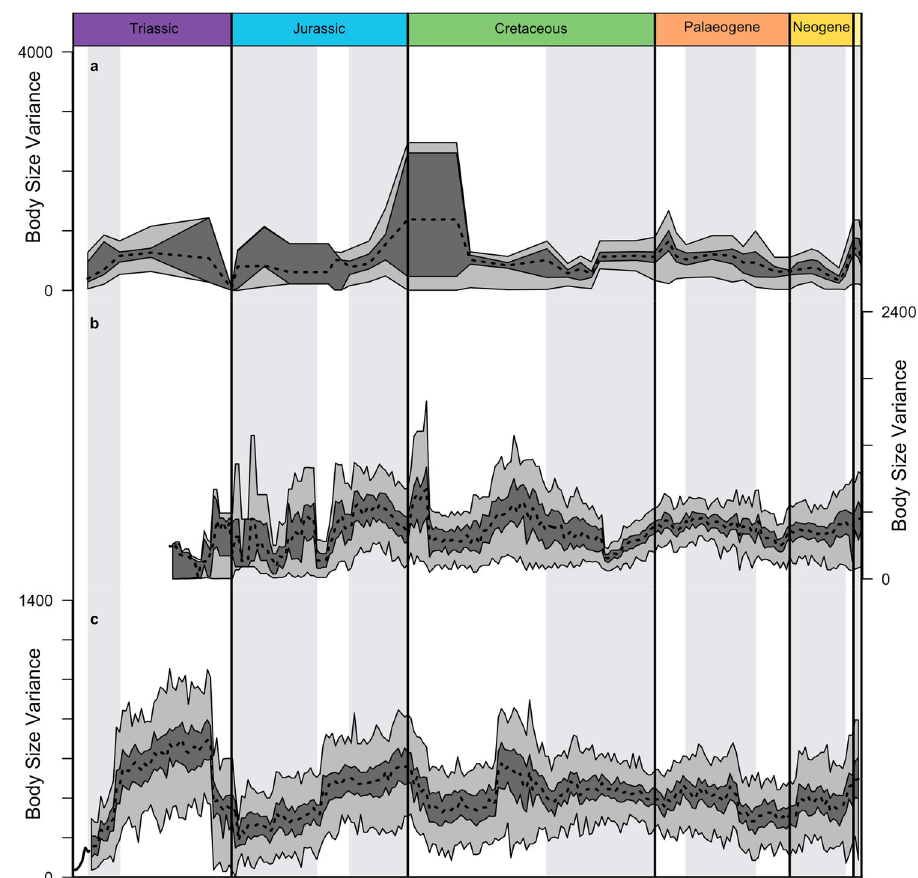
Fig. 2 Body size variance through time estimated using a dataset removed of exceptionally large taxa. Three curve estimation approaches are shown: a actual taxa binned at the resolution of stratigraphic stages; b actual taxa plus ghost ranges inferred using phylogenetic tree branch lengths; c actual taxa plus ghost ranges plus phylogenetically reconstructed body size values of inferred common ancestors. Data has been bootstrapped in a similar fashion to Fig. 3 of our original manuscript. Upper and lower quartiles of bootstrap values are shown in dark grey. The range of bootstrap values is shown in light grey. These curves compare favourably with our original publication and retain their most important